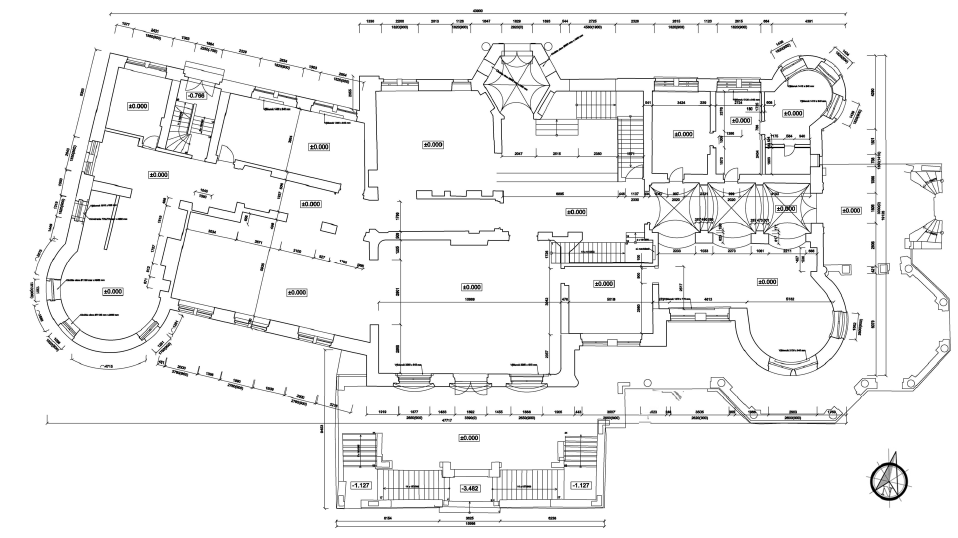
Figure 12. As-built documentation floor plan.